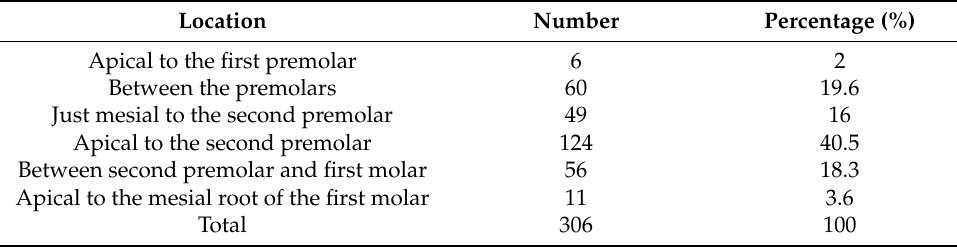
Table 2. Frequency analysis of the location of mental foramen. Location Number Percentage (%) Apical to the first premolar 6 2 Between the premolars 60 19.6 Just mesial to the second premolar 49 16 Apical to the second premolar 124